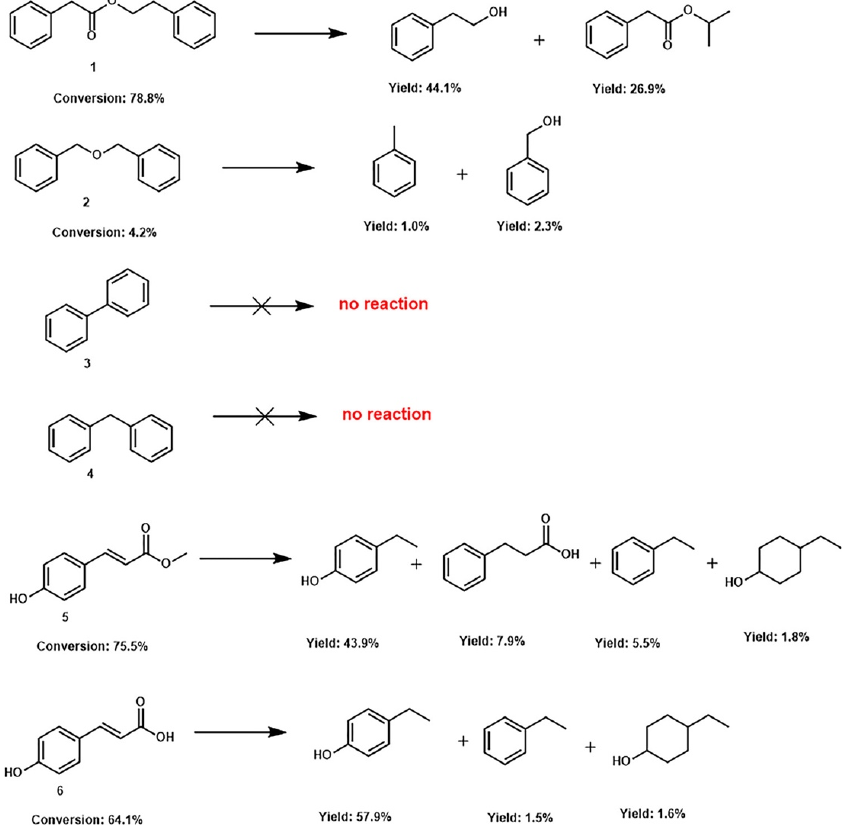
Figure 4. The hydrogenolysis performance of various lignin linkages differs. The following reaction conditions were used: 0.5 g of feedstock, 0.100 g of 20% Ni/MgO catalyst, 40 mL of isopropanol, 3.0 MPa H 2 , and 270 °C for 4 h [77].